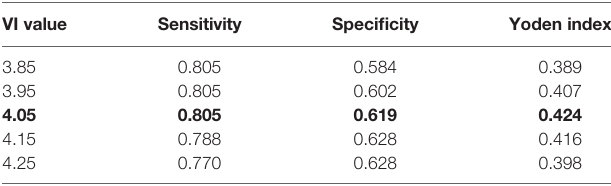
TABLE 2 | VI diagnostic performance with different cut-off